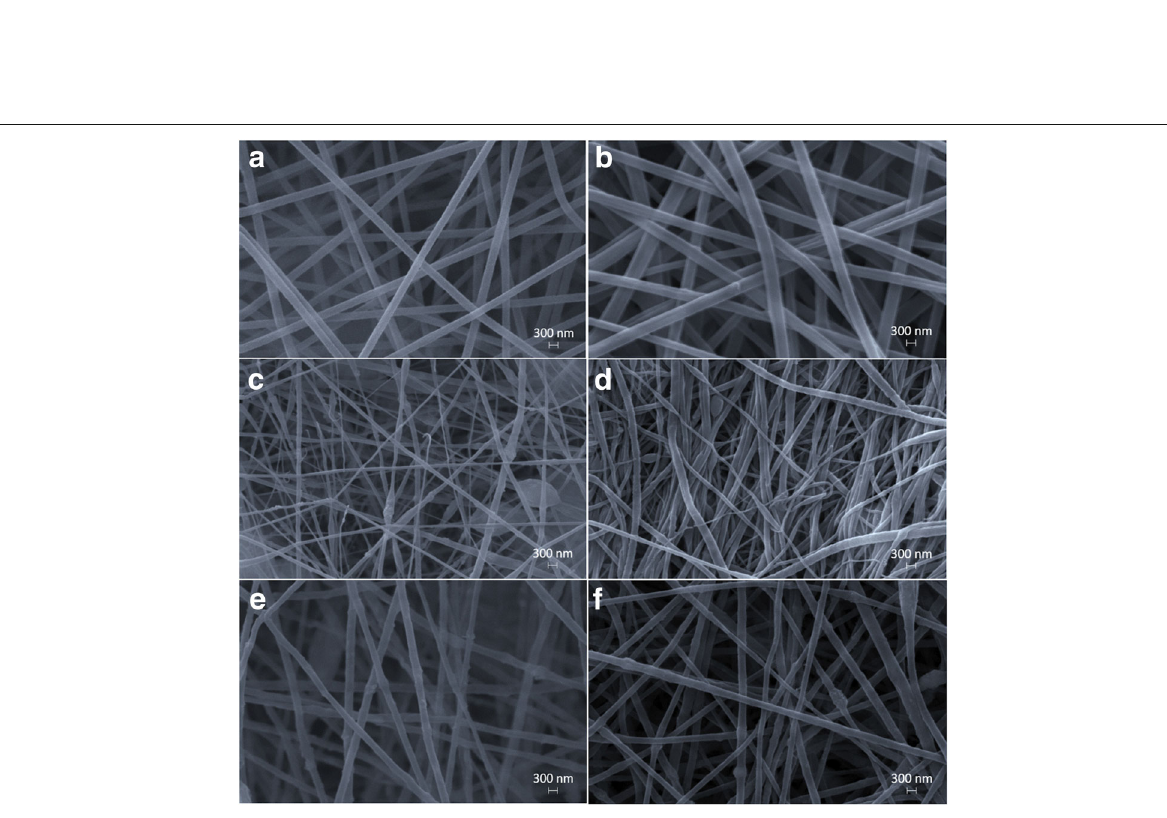
Fig. 3 SEM images a of PAN n- fib@Mat, b PAN n- fib@Mat after Cr (VI) adsorption, c PAN-ZnO n- fib@Mat, d PAN-ZnO n- fib@Mat after Cr (VI) adsorption, e PAN-ZnO-TiO 2 n- fib@Mat, and f PAN-ZnO-TiO 2 n- fib@Mat after Cr (VI) adsorption